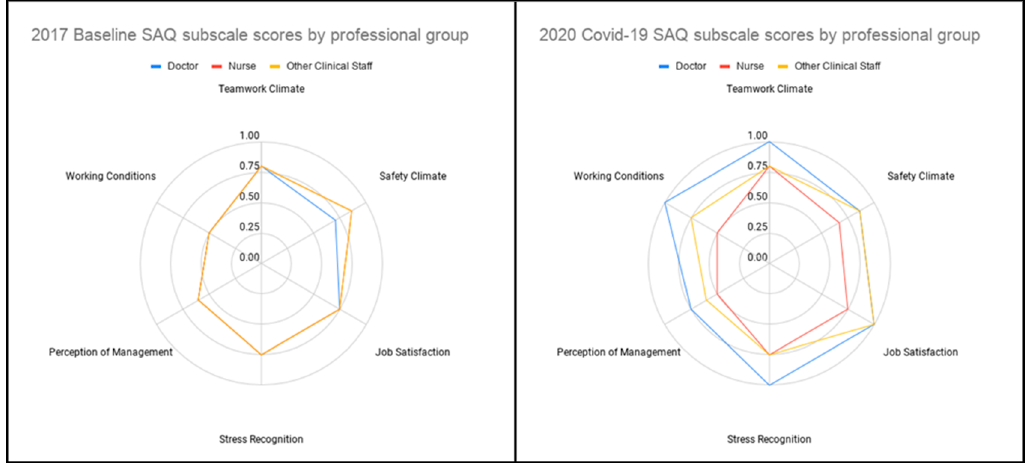
Figure 2. Radar plots demonstrating SAQ subscale scores by professional group in the baseline 2017